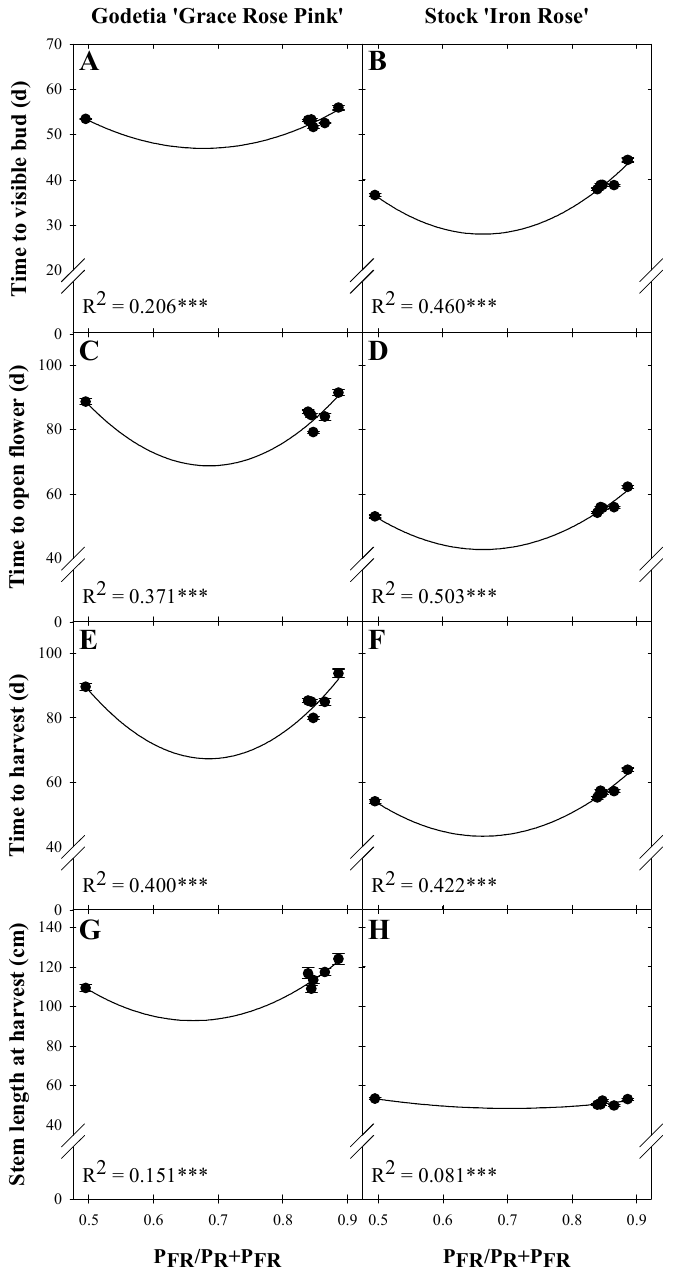
Figure 4. Influence of estimated phytochrome photoequilibrium (PFR/PR+PFR) of supplemental lighting treatments ( A , B ) on time to visible bud, ( C , D ) time to open flower, ( E , F ) time to harvest, and ( G , H ) stem length at harvest of godetia ‘Grace Rose Pink’ and stock ‘Iron Rose’. Black symbols represent means; error bars represent standard error. R 2 values are presented; *** indicate model significance at p < 0.00001. Coefficients are presented in Table